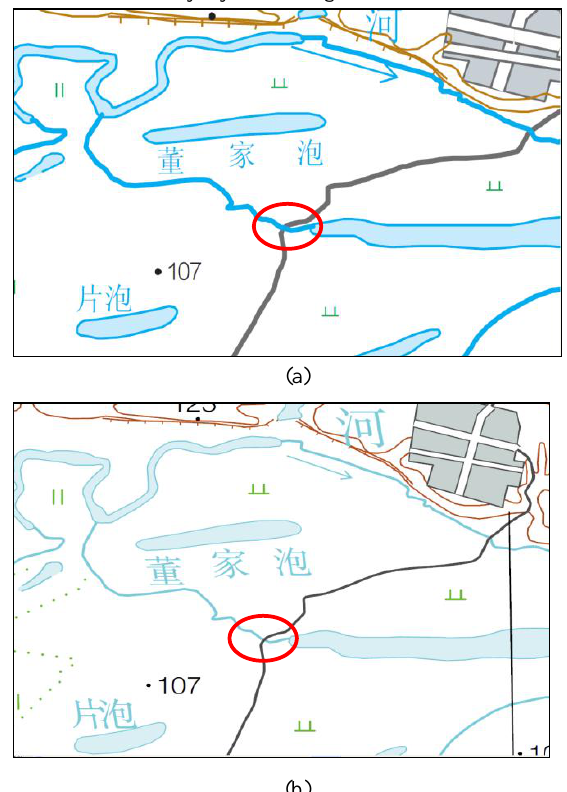
Fig.9 Conflicts between contour line and residential area solved by layer-level organization